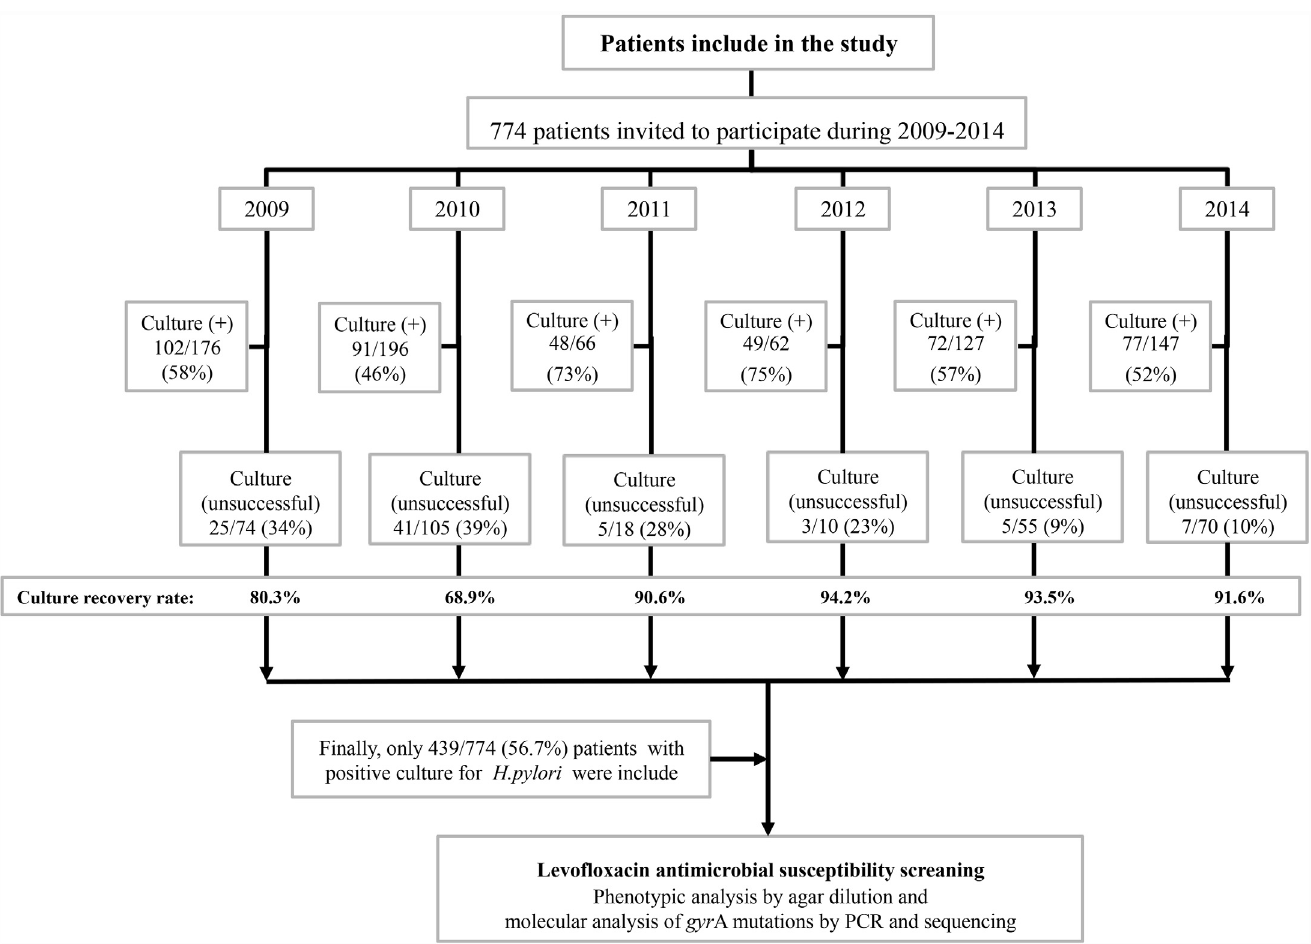
Fig 1. Patients included in the study. Diagram depicting details of number of patients/year and who was included in the study, based on H . pylori positive culture. Negative culture was related to H . pylori (negative), confirmed by histological analysis and rapid urease test or any other laboratory assay. Unsuccessful describes a sample where it was not possible to recover the isolate from a positive biopsy sample (positive for histological analysis and positive for rapid urease test and any other laboratory